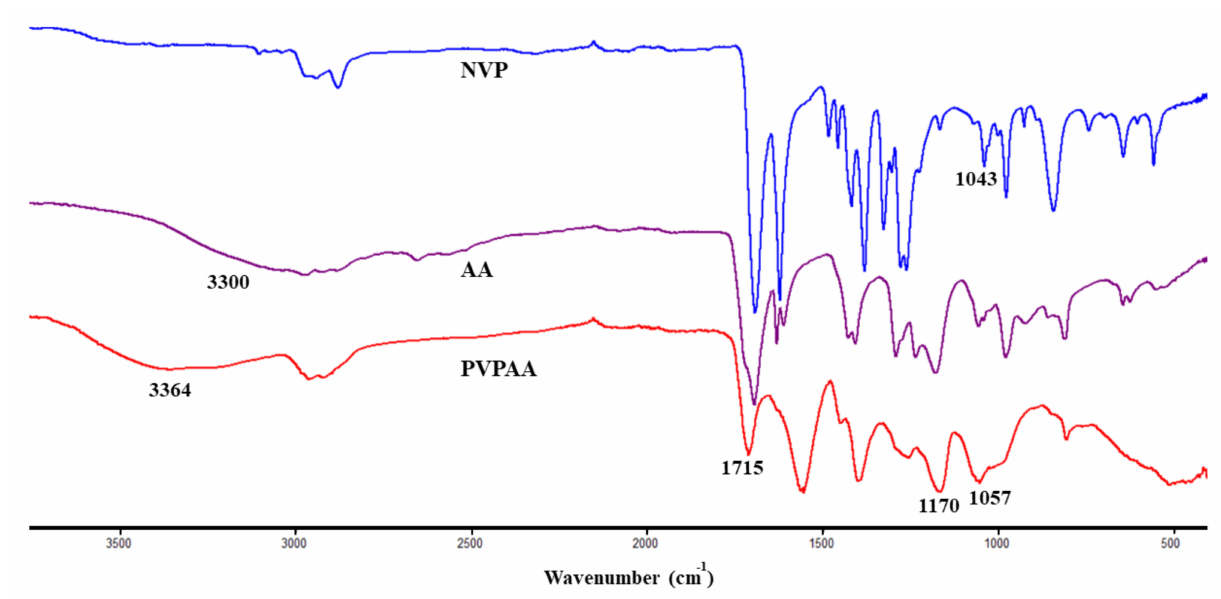
Figure 3. FT-IR Spectra of NVP, AA, and the synthesized PVPAA.